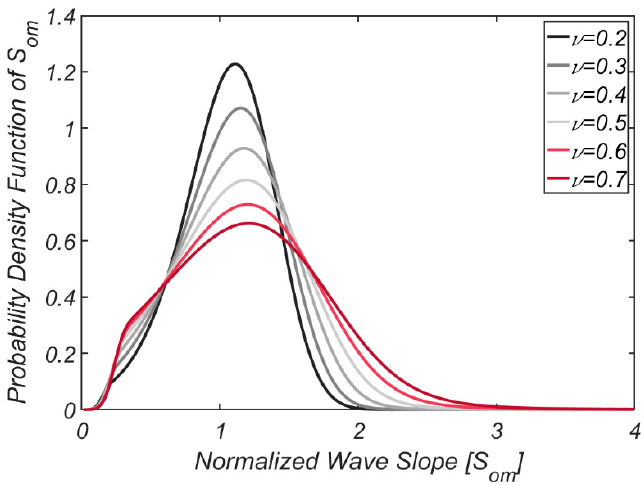
Figure 6. Probability density function of